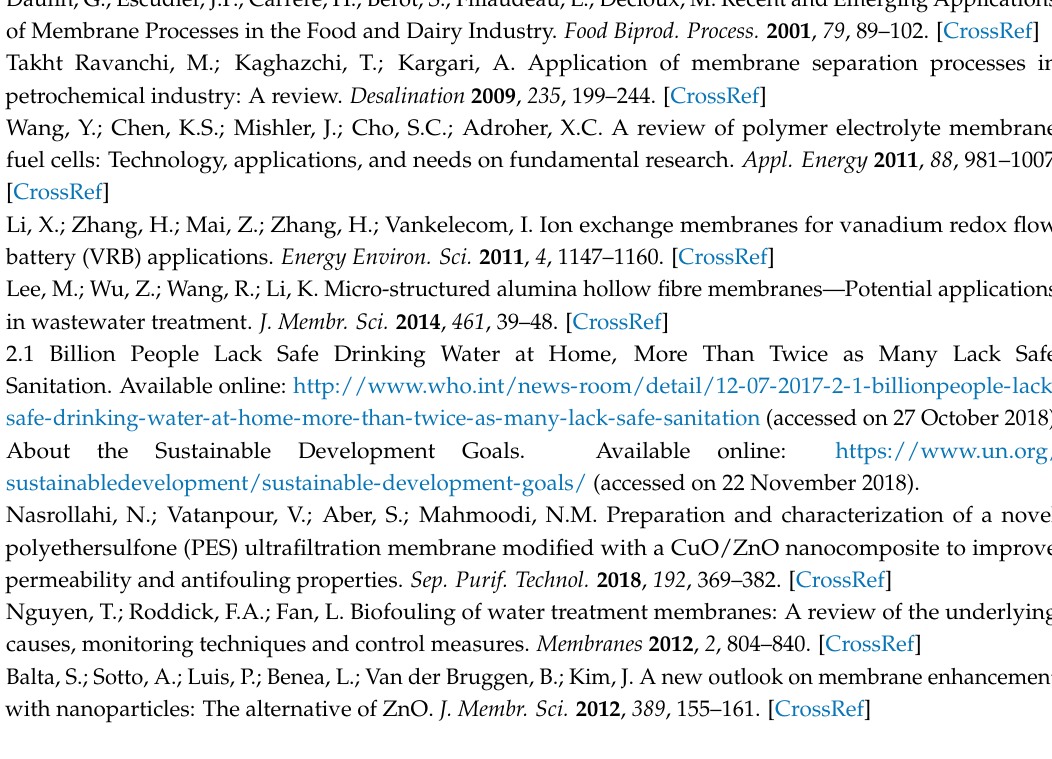
Figure S1: SEM micrographs of PZ1, PZ2, PZ3, PZ4, and PZ5 membrane (i). cross-section at 1200 × magnification and (ii). Top surface at 2000 ×